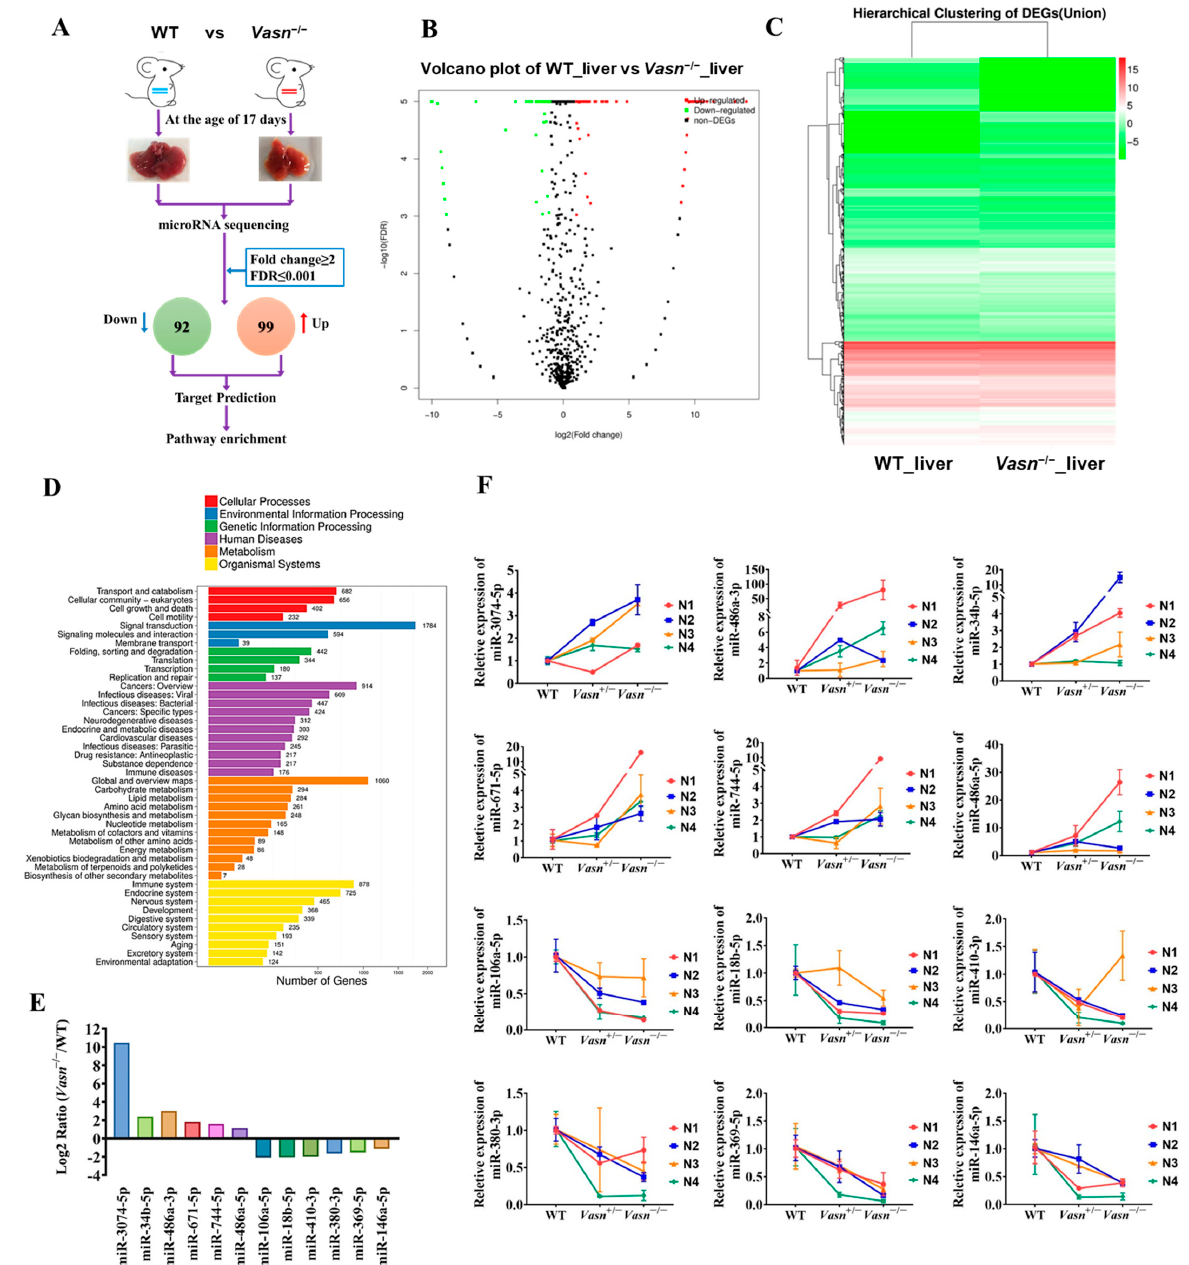
Figure 5. miRNA sequencing (miRNA-seq) analysis provided insight into the differences between the livers of Vasn KO homozygous mice and WT mice. ( A ) Schematic of miRNA-seq analysis performed on the livers of Vasn KO homozygous mice and WT mice. ( B ) Volcano plot showing differentially expressed miRNAs between the livers of Vasn − / − and WT mice. ( C ) Hierarchical clustering of gene expression between liver of Vasn KO homozygous Vasn − / − mice and WT mice; red: high expression, blue: low expression. ( D ) KEGG enrichment analysis. ( E ) miRNA sequencing results of miR-3074-5p, miR-486a-3p, miR-34b-5p, miR-671-5p, miR-744-5p, miR-486a-5p, miR-106a-5p, miR-18b-5p, miR- 410-3p, miR-380-3p, miR-369-5p, and miR-146a-5p in the liver of WT mice and homozygous mice Vasn − / − . ( F ) qRT-PCR analysis of the expression of miR-3074-5p, miR-486a-3p, miR-34b-5p, miR-671- 5p, miR-744-5p, miR-486a-5p, miR-106a-5p, miR-18b-5p, miR-410-3p, miR-380-3p, miR-369-5p, and miR-146a-5p in the liver of WT mice, heterozygote mice Vasn +/ − , and homozygous mice Vasn − / − . Twelve mice from WT, Vasn +/ − , and Vasn − / − groups were then allocated to different blocks (N1, N2, N3, and N4) using a randomized block